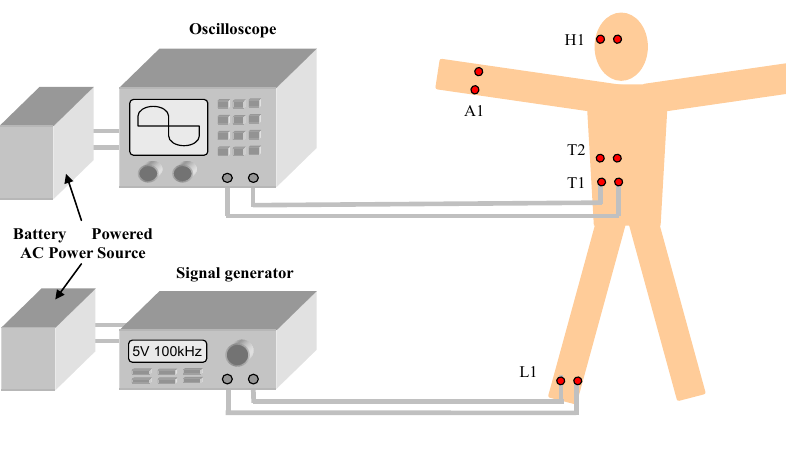
Figure 8. The measurement